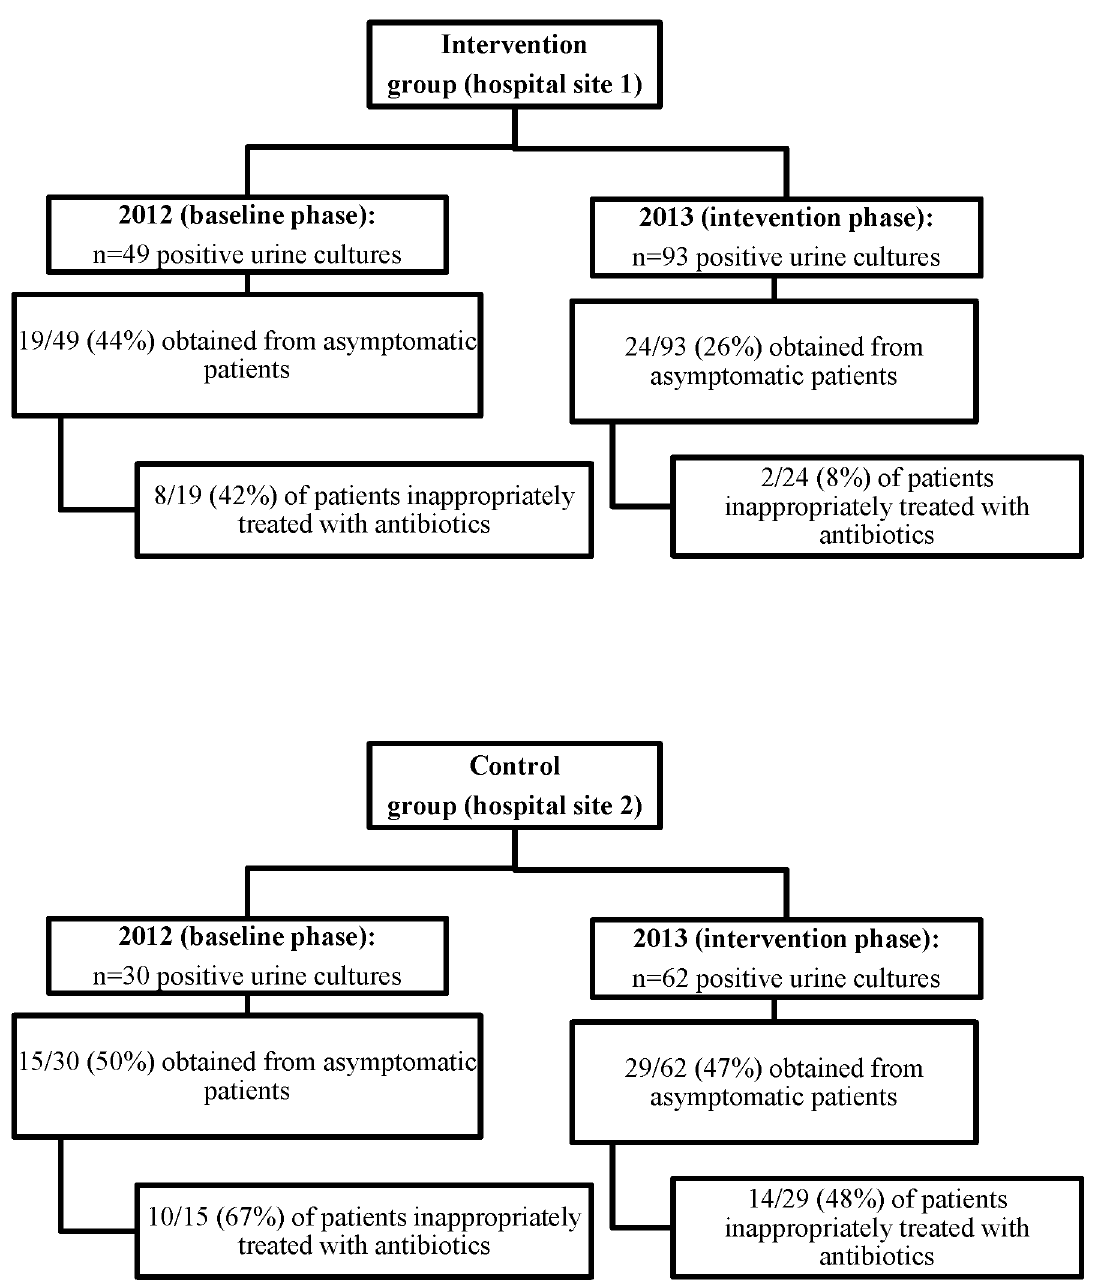
Fig 2. Flow chart of the baseline and intervention phase on the internal medicine teaching units. a) Intervention group. b) Control group.